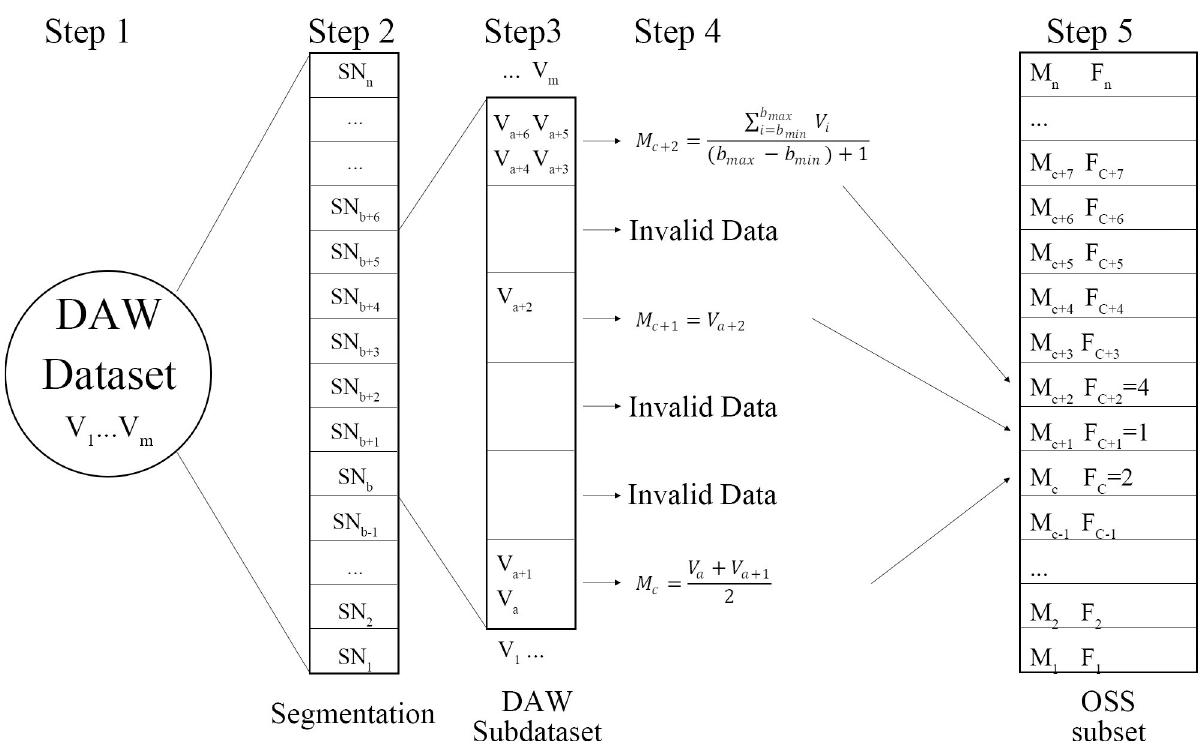
Fig 2. Monitoring window data set segmentation and effective segmentation statistical set calculation method.